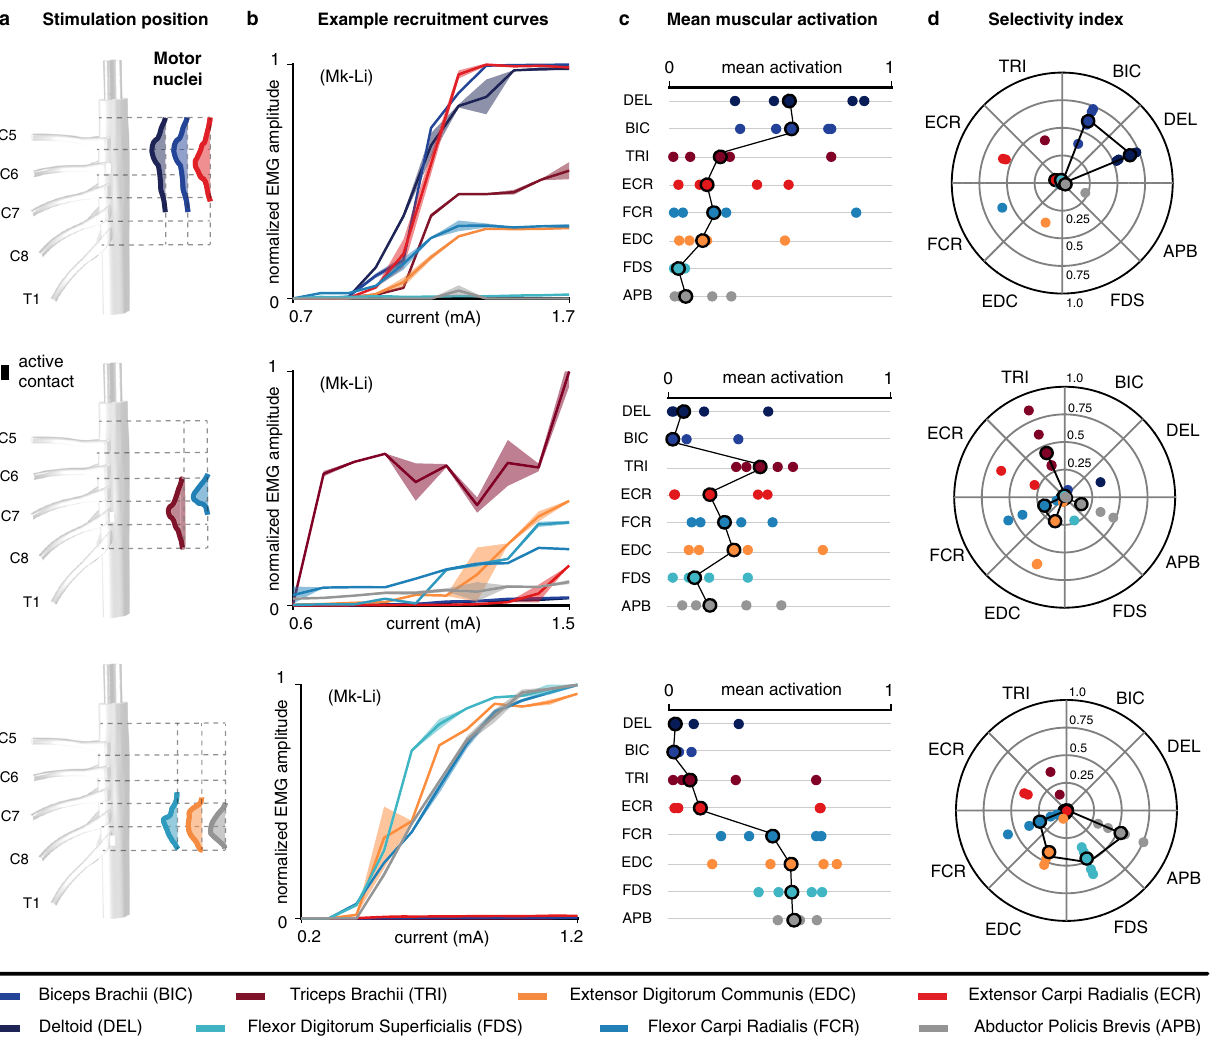
Fig. 4 Muscular recruitment induced by laterally-positioned electrodes in the cervical spinal cord of monkeys. a Approximate positions of the electrodes used to obtain the results in ( b – d ) and underlying motoneuronal distributions. Electrode contacts are magni fi ed for better visualization (scale factor: 2). b Examples of muscular recruitment curves observed in monkey Mk-Li using one rostral, one intermediately rostral, and one caudal electrodes. Curves are made of 11 data points consisting of the mean and standard deviation of the normalized peak-to-peak EMG amplitude across four responses induced at the same stimulation current. c Mean muscular activations observed in 5 monkeys. One rostral, one intermediately rostral and one caudal electrodes were chosen for each animal, and the observed mean muscular activations (see “ Methods ” ) reported as individual bullets (for Mk-Li, the same active contacts as in ( b ) were used). d Maximal selectivity indexes (see “ Methods ” ) obtained for each muscle and each animal with the same electrodes as in ( c ). Circled bullets: medians across the fi ve